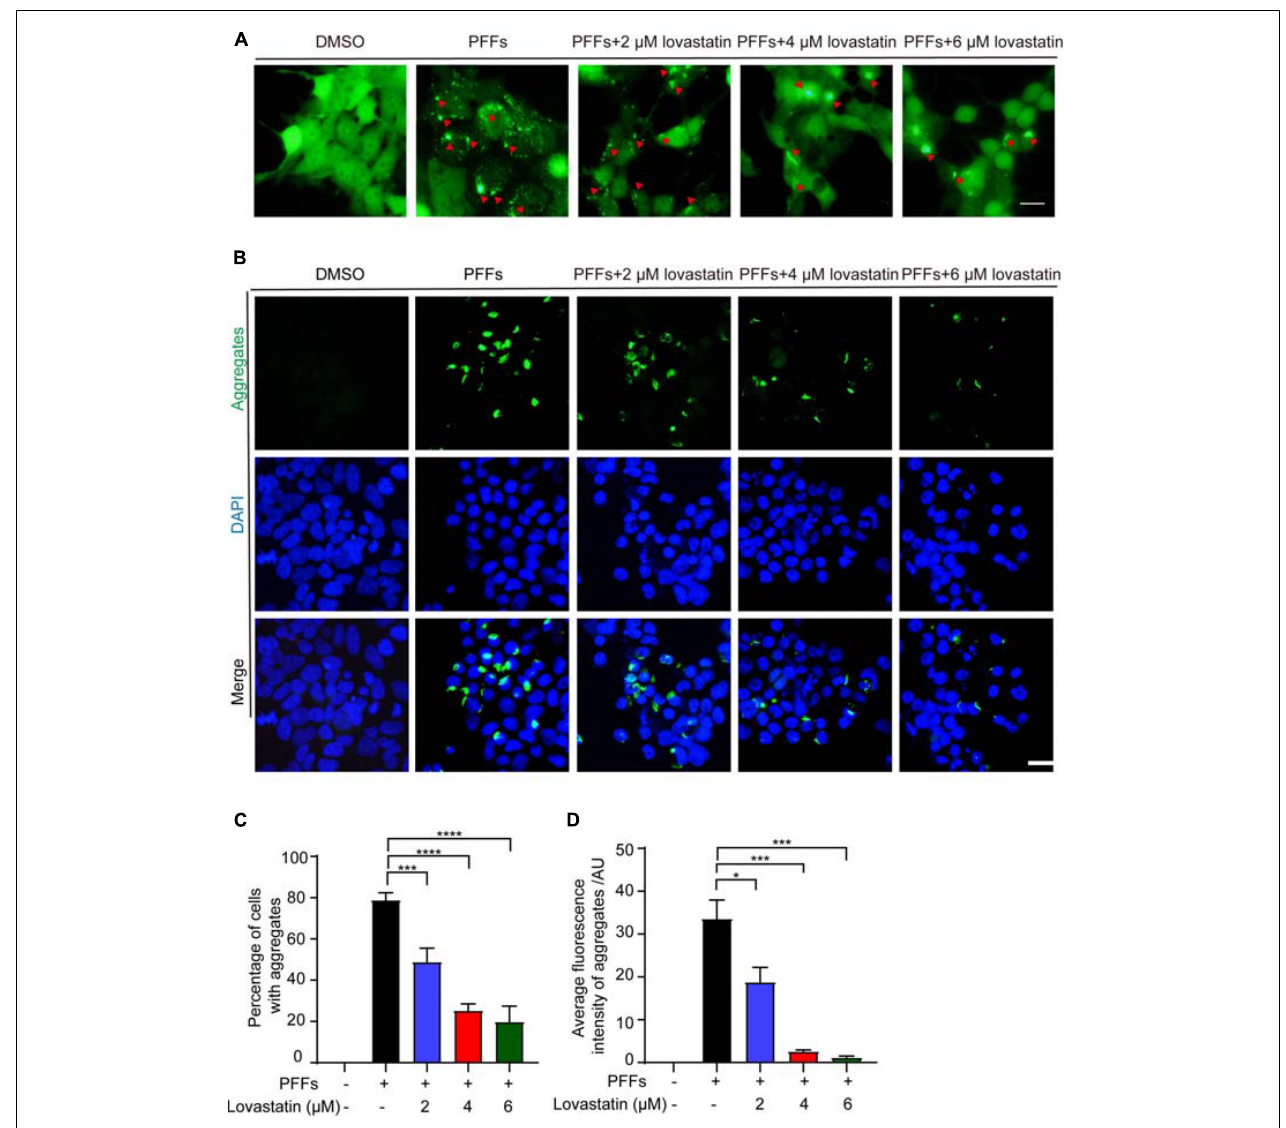
FIGURE 1 | Lovastatin inhibits α -syn aggregation in GFP- α -syn-HEK293 cells. (A) Intracellular α -syn aggregates assay. Green aggregates indicate α -syn aggregates. The aggregates in the lovastatin group were significantly reduced compared with the α -syn-PFFs group. (B) Insoluble α -syn aggregates after permeabilization. Compared with the α -syn PFFs group, the insoluble α -syn aggregates (green) was significantly reduced in the lovastatin group. (C) Counting of α -syn aggregates. At least 120 cells from more than three fields were counted in the experiments. (D) Quantification of the insoluble α -syn (data are means ± SEM, * P < 0.05, *** P < 0.001, and **** P < 0.0001, one-way ANOVA with Tukey’s multiple comparisons test). Bar = 20 µ m. AU, Arbitrary